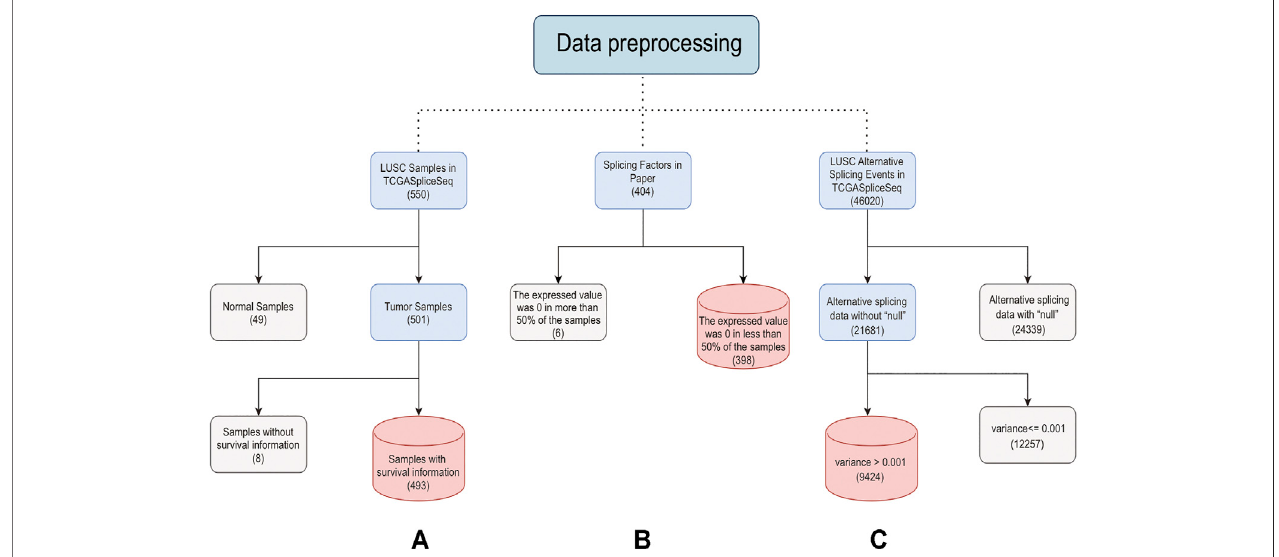
FIGURE 1 | Steps of data preprocessing. The solid line represents the preprocessing process. The light blue box represents the data to be processed. The gray boxrepresentstherejecteddata.Theredboxrepresentsthelastretaineddata.Thenumbersinbracketsrepresentthedataamount. (A) isthepreprocessingprocessof samples, (B) is the preprocessing process of SFs, and (C) is the preprocessing process of